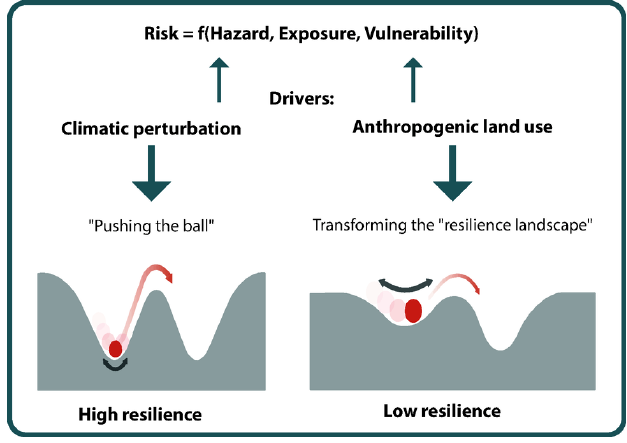
Fig. 2. Conceptualization of the proposed risk-resilience model for land degradation. Based on a combination of the “ball-in-a- cup” model for ecological resilience (adapted from Popkin 2014) and the classical risk function developed within disaster risk research. Figure adapted from von Keyserlingk